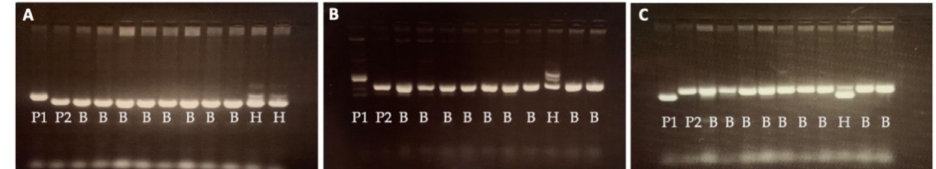
Figure 1. Marker-assisted selection of progeny (BC 3 F 4 ) using RM markers tightly linked to Gn1a and flanking the WFP . ( A ) Progeny were screened using RM3360 for the Gn1a allele; ( B ) progeny were screened using RM5493; ( C ) progeny were screened using RM3452 for the WFP allele. A, B, and H refer to the recipient (P1), donor (P2), and heterozygous genotypes, respectively.